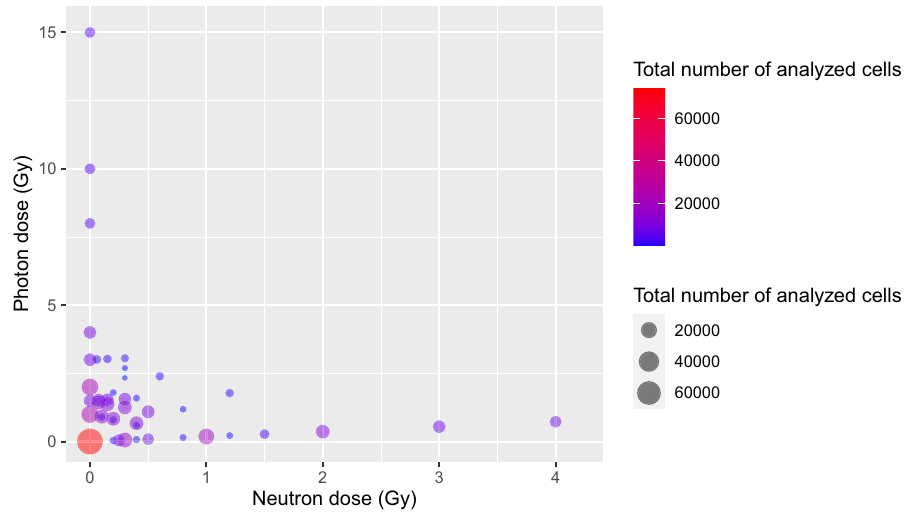
Figure 1. Summary of the analyzed data set on radiation-induced micronuclei in ex vivo irradiated peripheral blood lymphocytes. Each circle represents a specific combination of neutron and/or photon doses. The same data are listed numerically in Supplementary Table